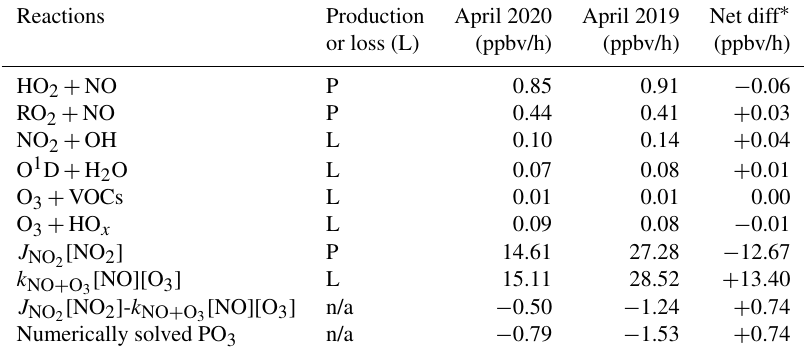
Table 2. Reaction rates relating to the chemical pathways of ozone formation and loss over box L (proximity of central Europe). n/a – not applicable Reactions